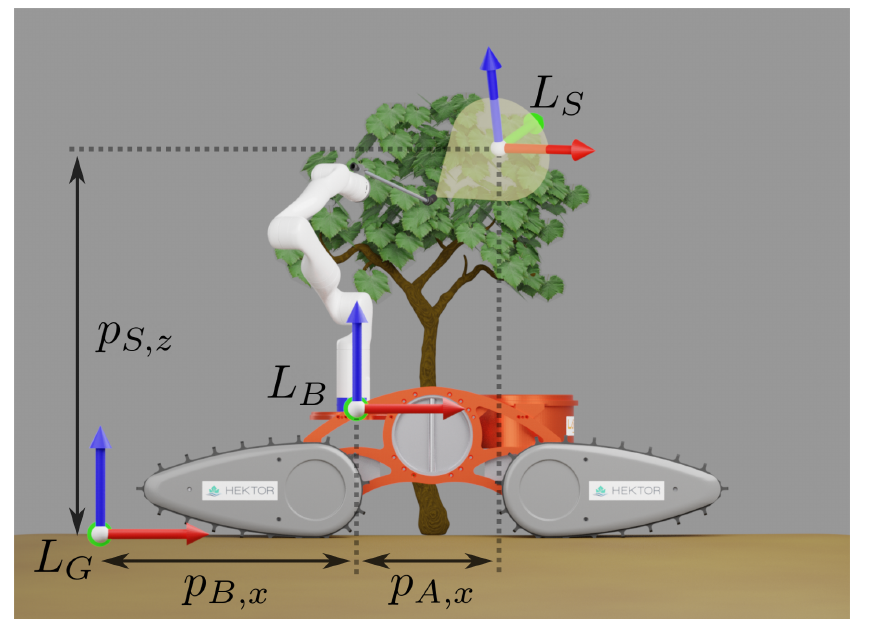
Figure 2. Three coordinate frames are defined: a global frame at the ground level L G , mobile base frame L B and the spray frame L S . The x , y and z axes of the coordinate frames are represented with red, green and blue arrows,